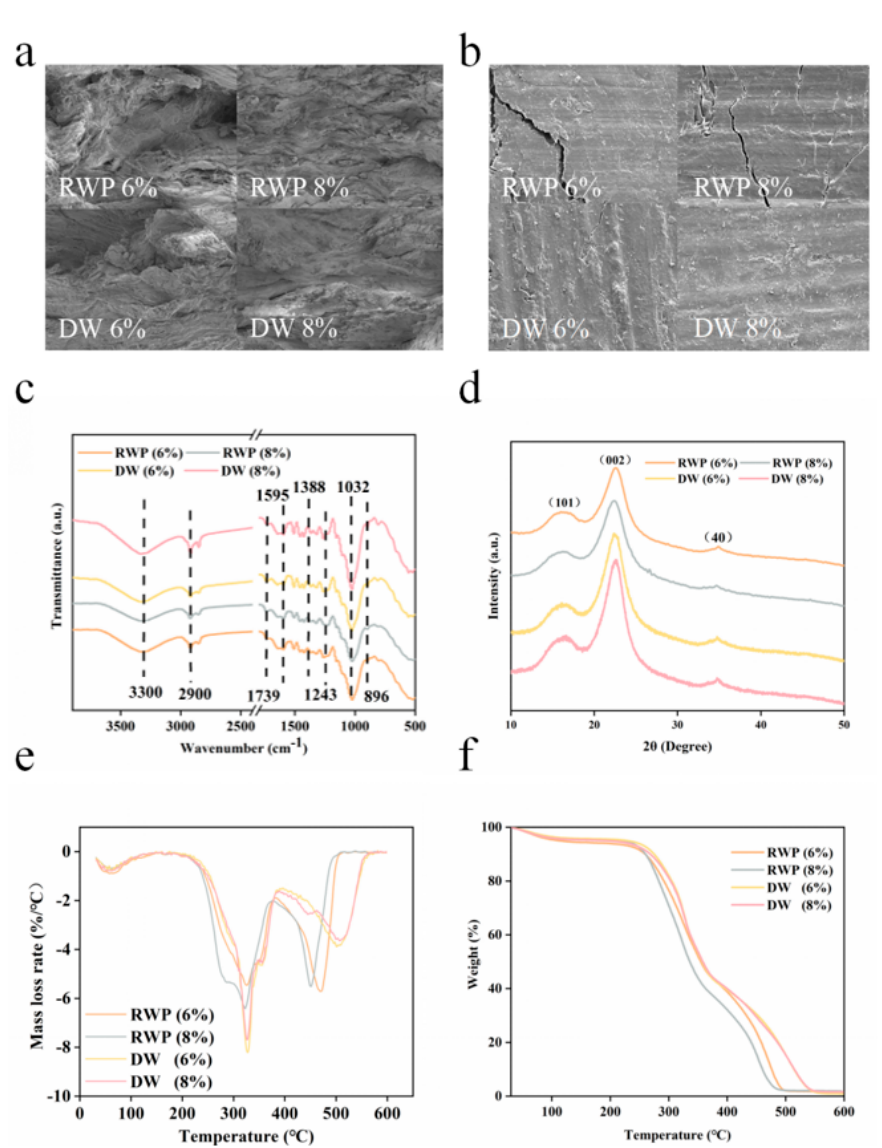
Figure 4. ( a ) Comparison of cross − sectional electron micrographs; ( b ) Comparison of surface electron micrographs; ( c ) Comparison of FTIR; ( d ) Comparison of XRD; ( e ) Comparison of weight-loss rate; ( f ) Comparison of thermogravimetric